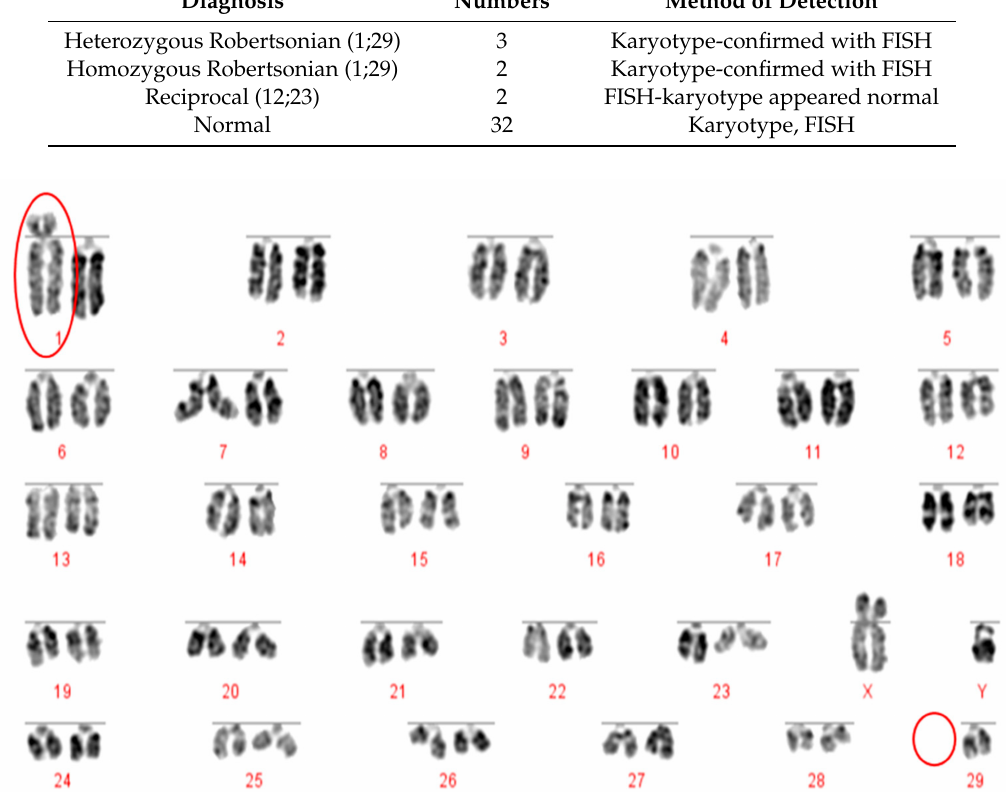
Figure 2. DAPI stained karyotype of a 2n = 59 bull with a rob (1;29). Robertsonian translocation and the missing chromosome 29 are circled in